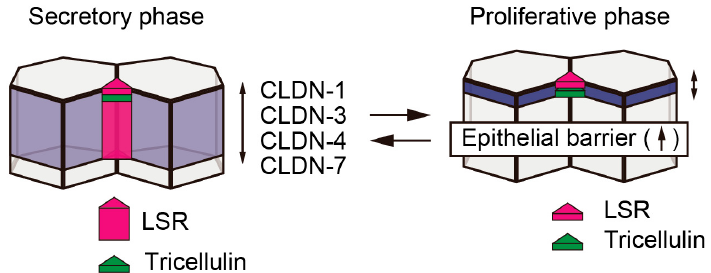
Figure 1. The localization of tight junction proteins is affected by menstrual cycle. In secretory phase of human endometrium, CLDN-1, -3, -4, and -7 are widely distributed to the lateral region. Tricellulin localized in tricellular contacts of the subapical region, whereas LSR is widely distributed to the lateral region. In proliferative phase, CLDNs localized in the subapical tight junction region. Tricellulin and LSR localized in the subapical tricellular contacts.